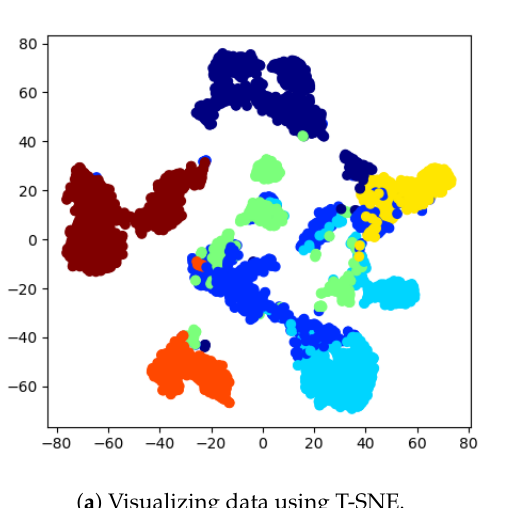
Figure 7. Confusion matrix.